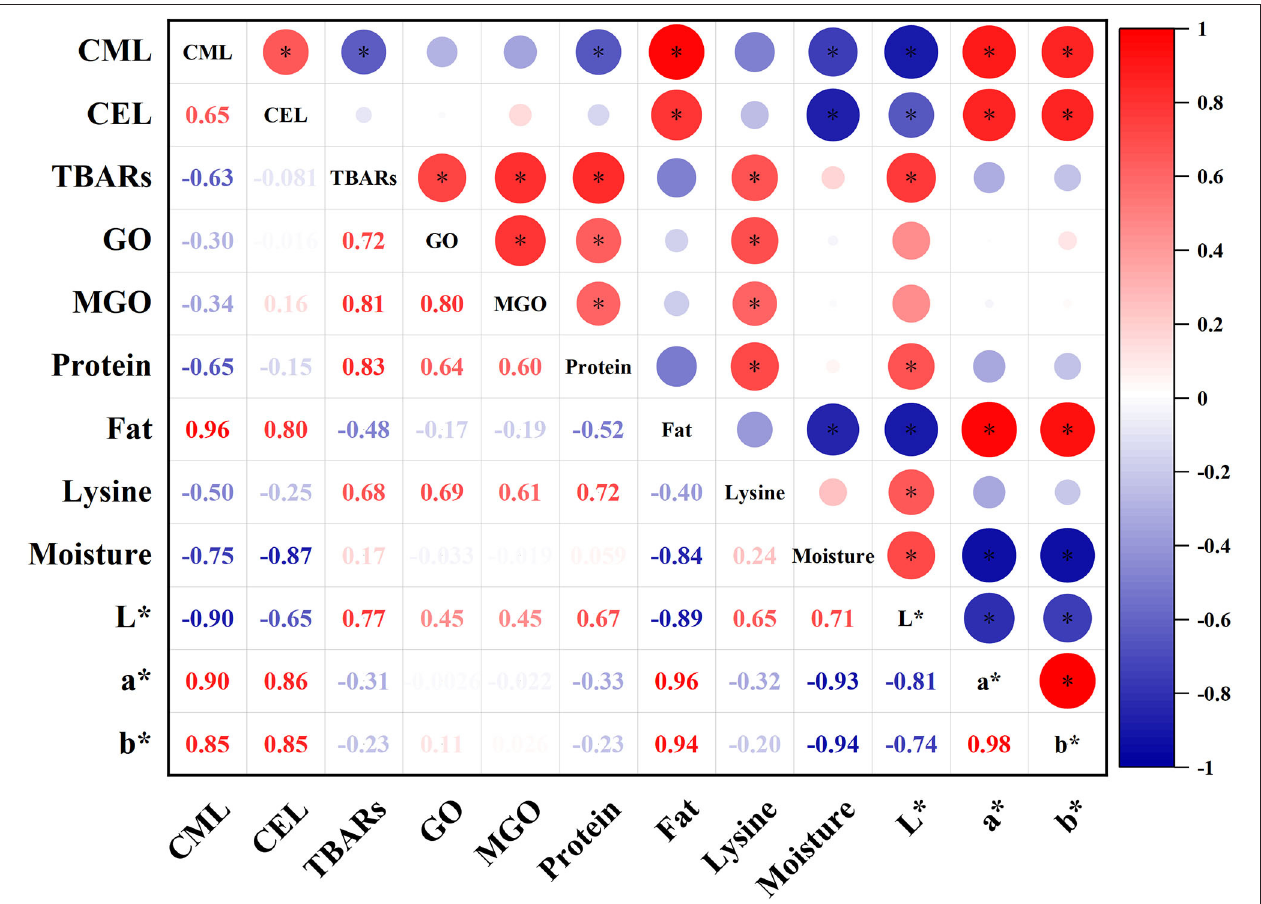
FIGURE 5 | Correlation analysis of all parameters measured in this research of oysters under different thermal processing conditions. Asterisk (*) indicated significant correlation ( p < 0.05).